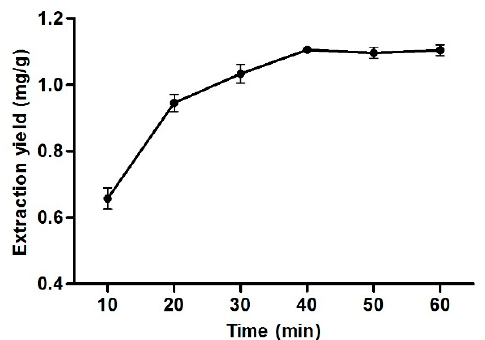
Figure 10. Effect of the solid-liquid ratio on the extraction yield of rutaecarpine. La-Buta DES aqueous solution with 1:0.5 molar ratio containing 25% water was used as a solvent to extract at a solid-liquid ratio of 1:30 with ultrasound at 55 °C and 500 W for different times. The data represent mean ± S.D. of triplicated experiments.